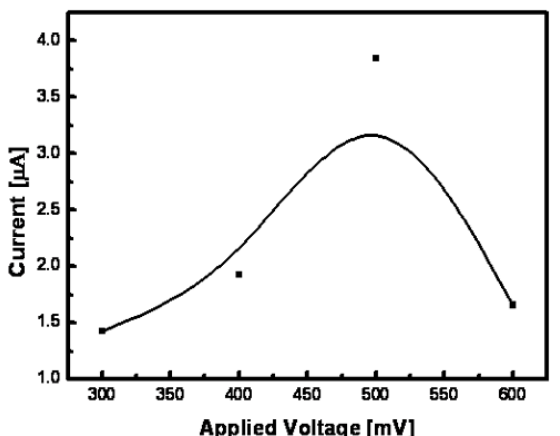
Figure 7. Effects of applied potential on the current response of fabricated non-enzymatic glucose micro-sensor at 1 mmolL -1 glucose concentration (pH